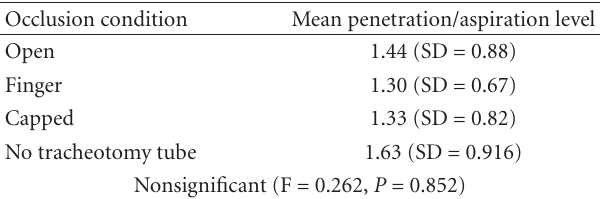
Table 3: Mean penetration-aspiration level by occlusion